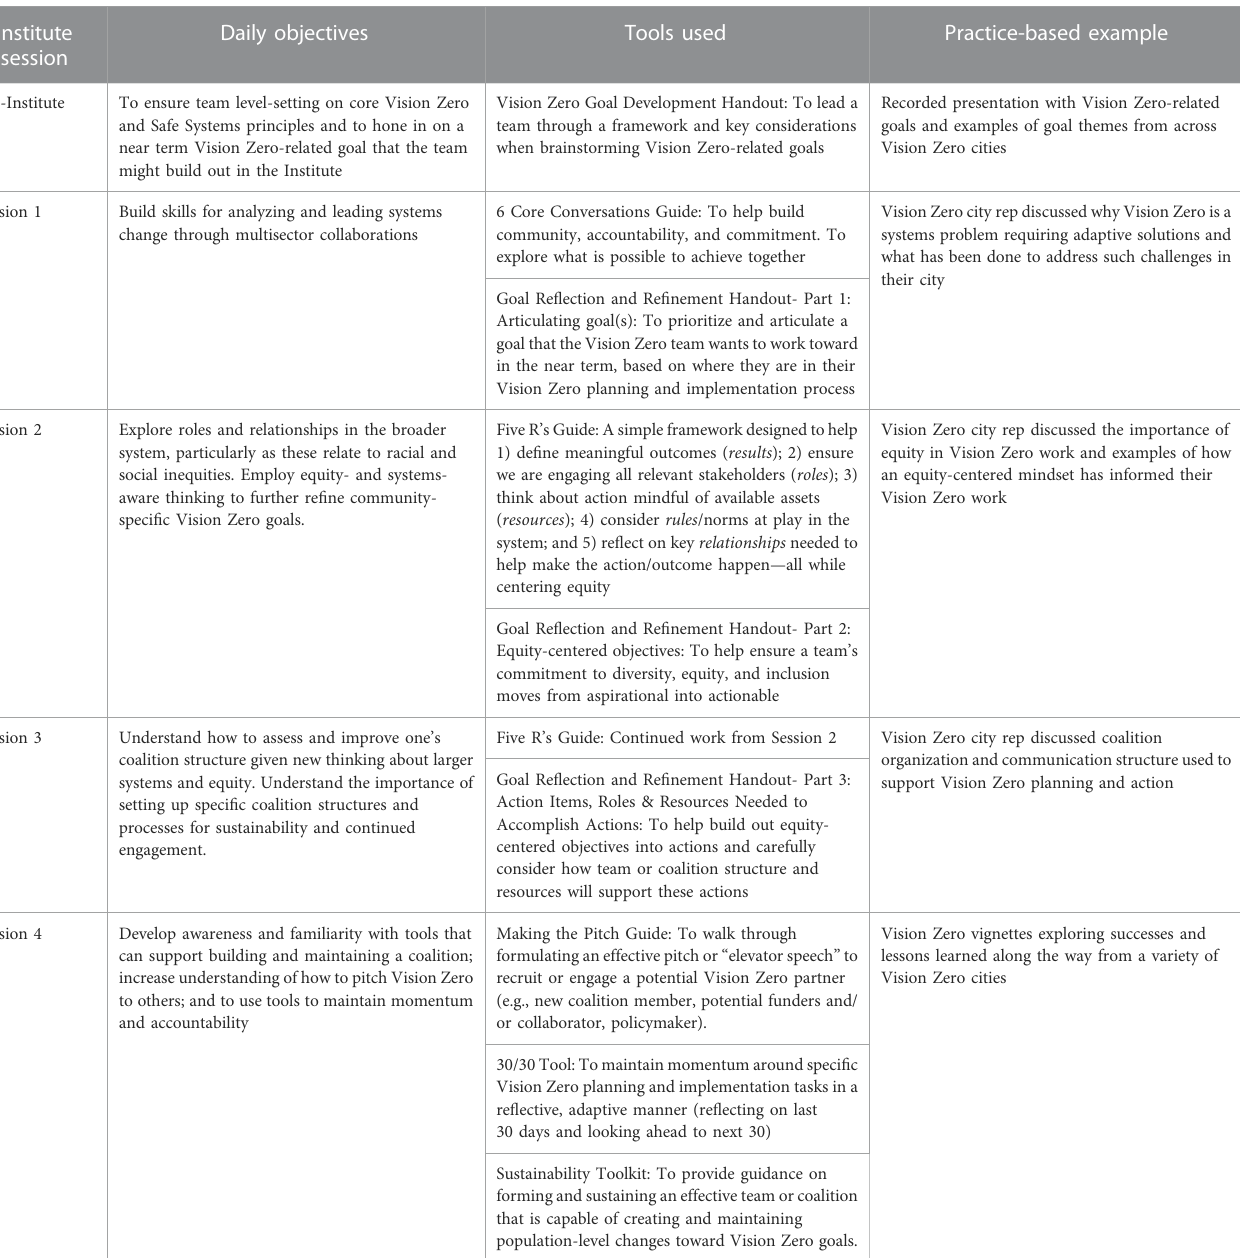
TABLE 1 Overview of Vision Zero Institute objectives, tools used, and connections to practice-based examples. Institute